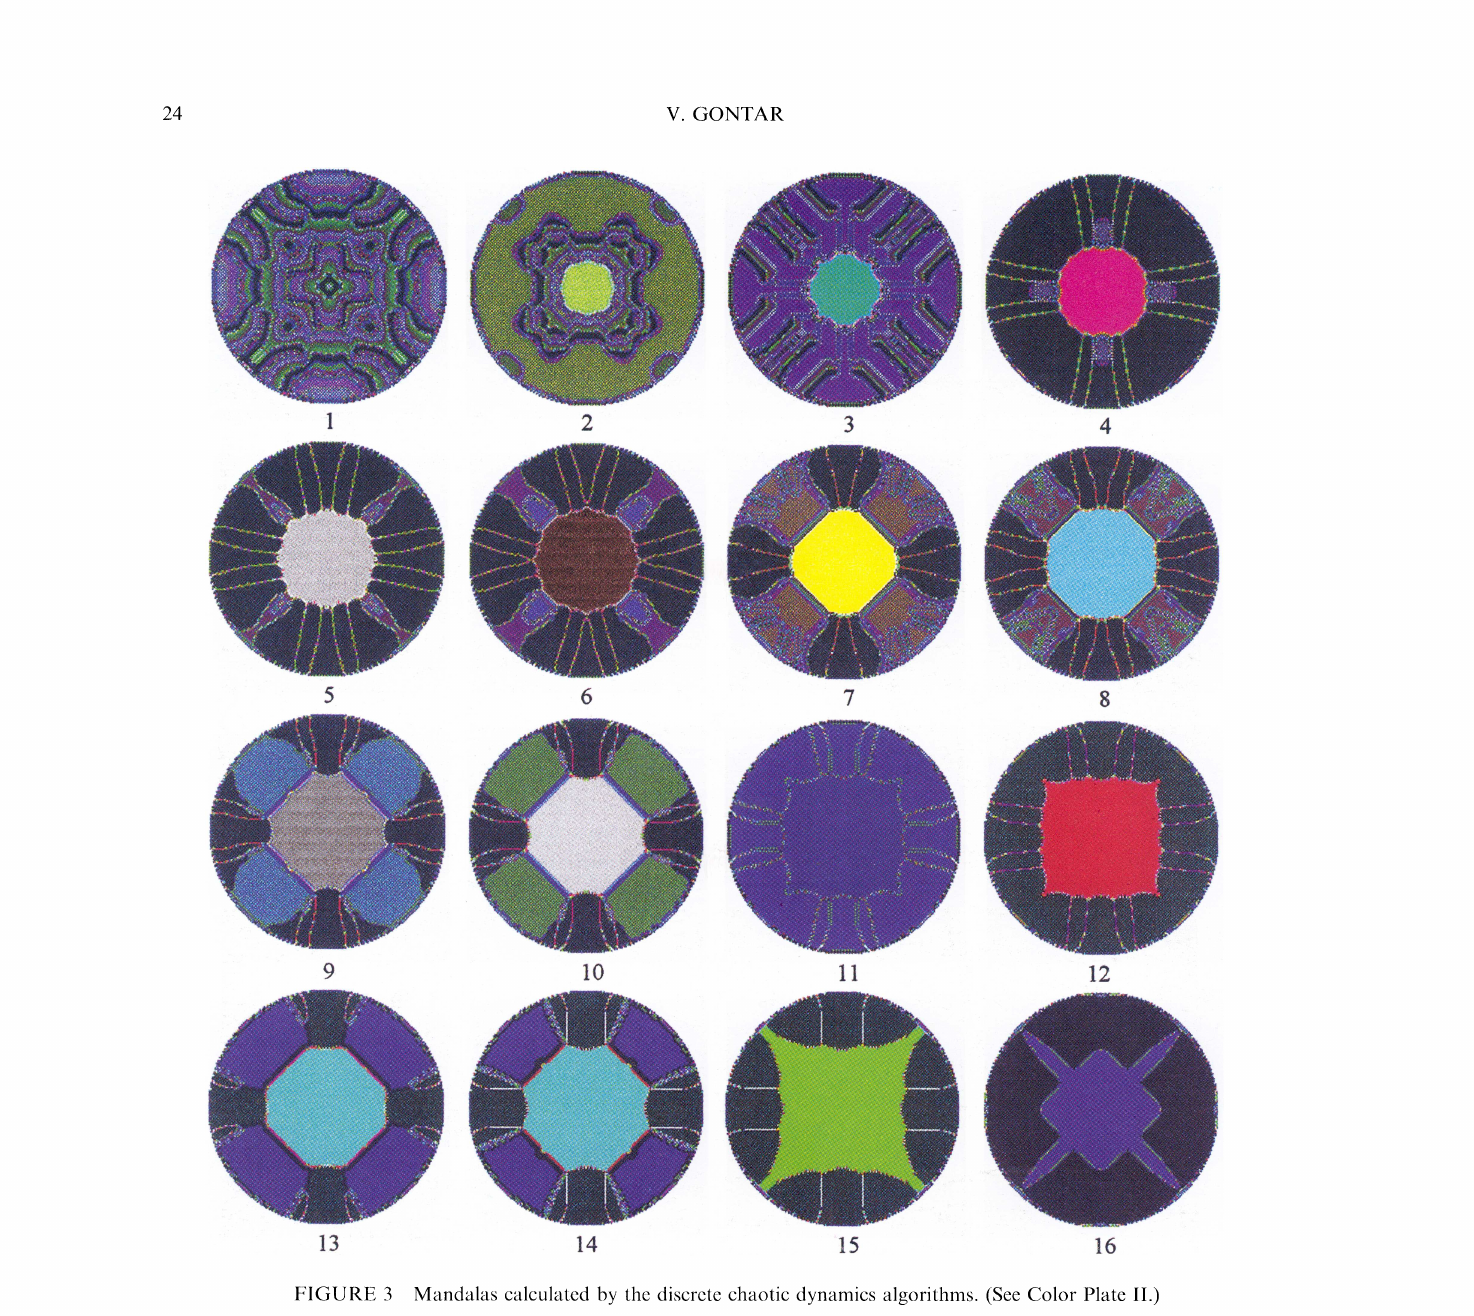
FIGURE 3 Mandalas calculated by the discrete chaotic dynamics algorithms. (See Color Plate